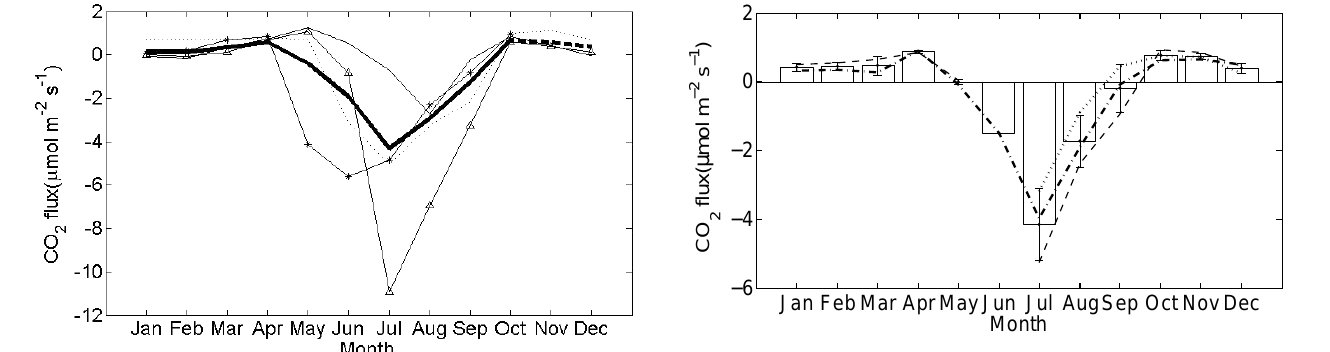
Figure 2. Monthly averages of CO 2 flux in 2007 (dotted line), 2008 (dot-dashed line), and 2009 (dashed line) measured with EC on the tall tower. White bars are the mean monthly value from the avail- able data during the 3-year observation period. Error bars on the top of white bars show the lower and upper boundary of the 3-year measurements for each